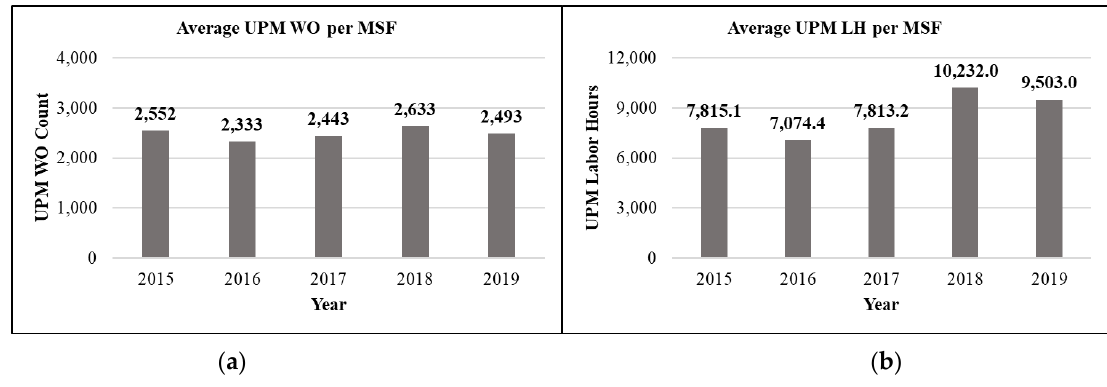
Figure 8. Five-year trend of UPM: ( a ) Work Order Counts; ( b ) Labor Hours.